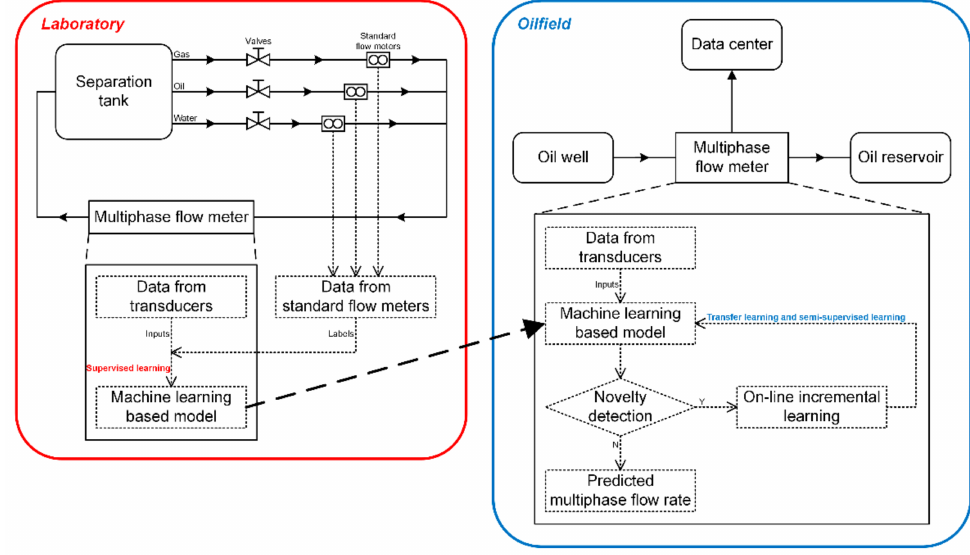
Figure 9. The machine-learning-based data analytics framework for measurement of multiphase